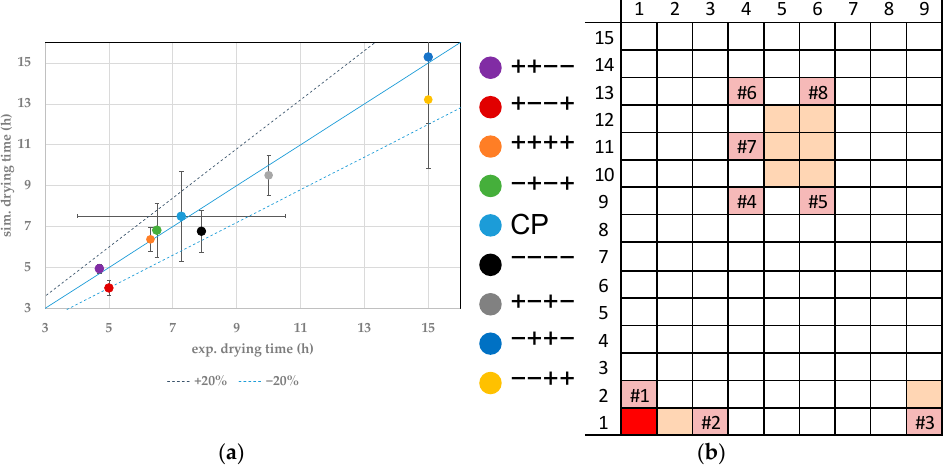
Figure 4. ( a ) Parity plot between simulated and experimental primary drying endpoints for vial 1.1. ( b ) Color legend for experiments and vial position (red: shown vial, orange: other probed vials, pink: WTMplus sensor position and WTMplus number).